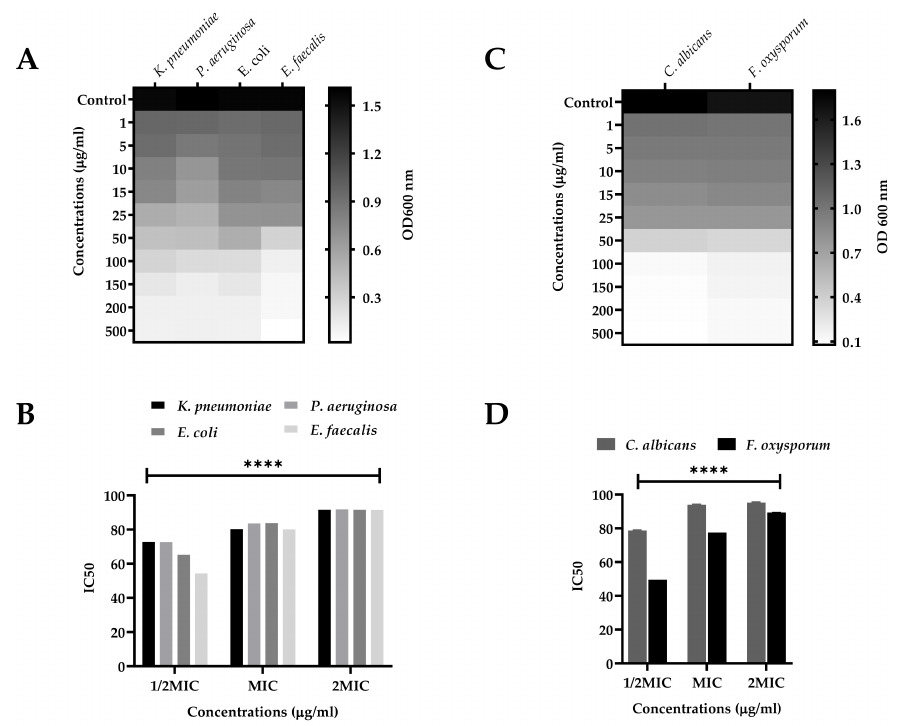
Figure 2. ( A , B ) antibacterial OD 600nm and IC 50 of Klebsiella pneumoniae, Pseudomonas aeruginosa , Escherichia coli, and Enterococcus faecalis against various concentrations of essential oil of S. edelbergii; ( C , D ) Antifungal OD 600nm and IC 50 of the potential of essential oils of S. edelbergii against Candida albicans and Fusarium oxysporum against various concentrations. Data were taken in triplicate ( n = 3) and analyzed through two-way ANOVA, via Tukey’s multiple comparison test, p = **** < 00.0001).